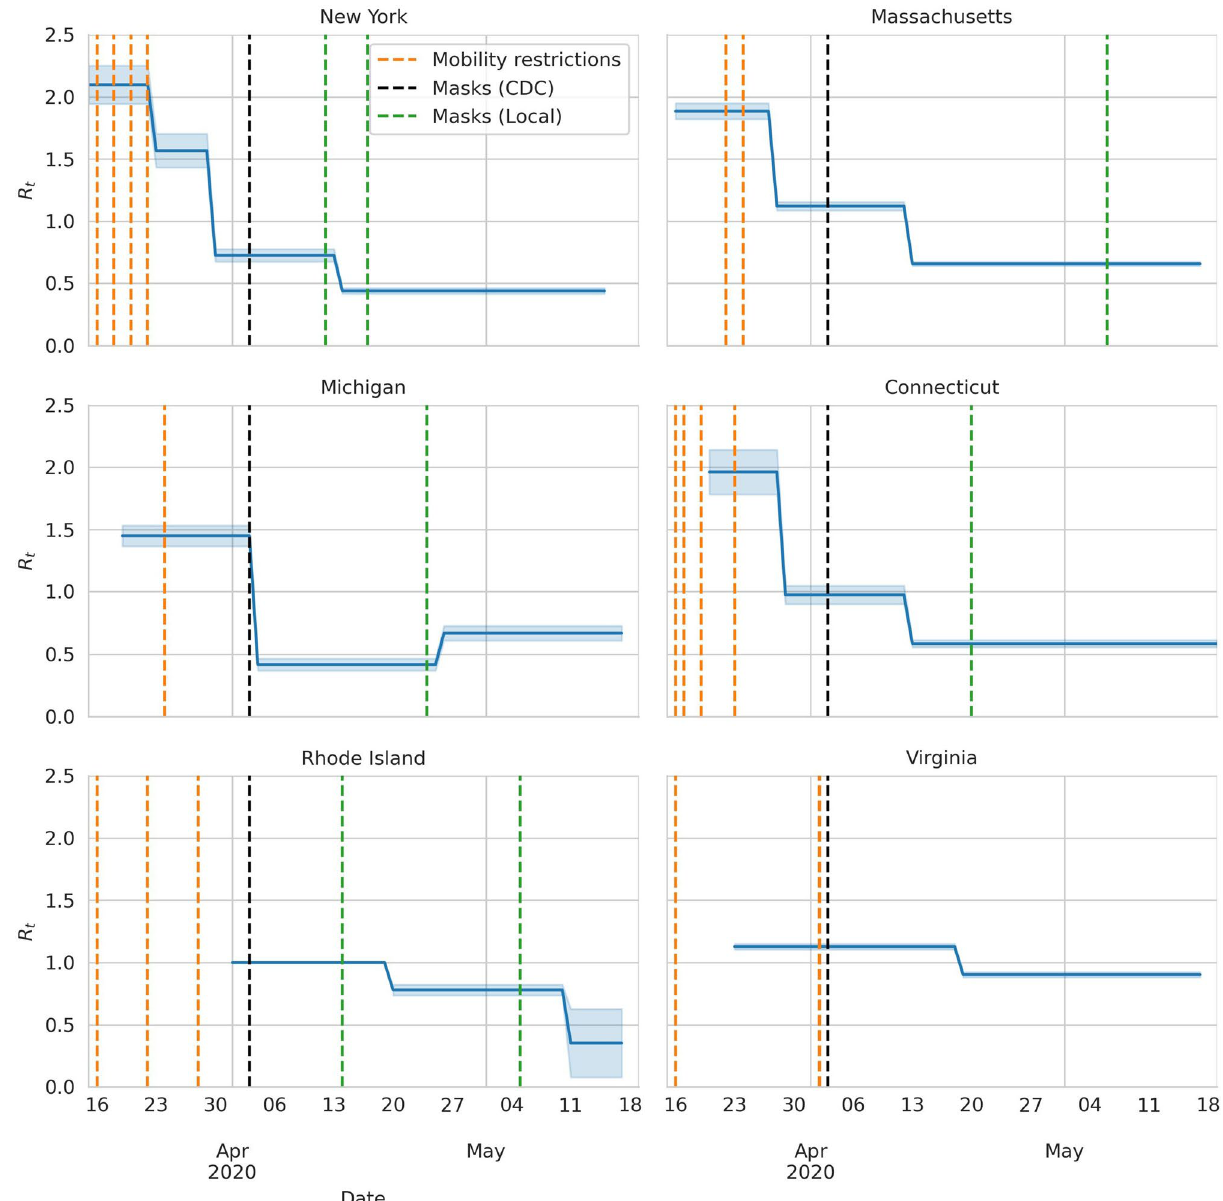
Figure 3. R t as a function of time. The dashed vertical lines indicate different governmental interventions. Once in place, each intervention remained in effect during the whole presented period. Orange lines indicate mobility restriction orders such as closing bars, gyms, movie theaters, schools, and banning non essential work. The black line show the moment at which the CDC updated its guidelines to recommend wearing masks. The green lines show moments at which the local states changed their guidelines regarding masks. NY and RI enforced the use of masks for some jobs first, and later on they enforced mask wearing policies among the general public. MA and CT enforced the use masks by the general public. MI only enforced the use of masks in enclosed public areas, such as grocery stores. VA never enforced the use of